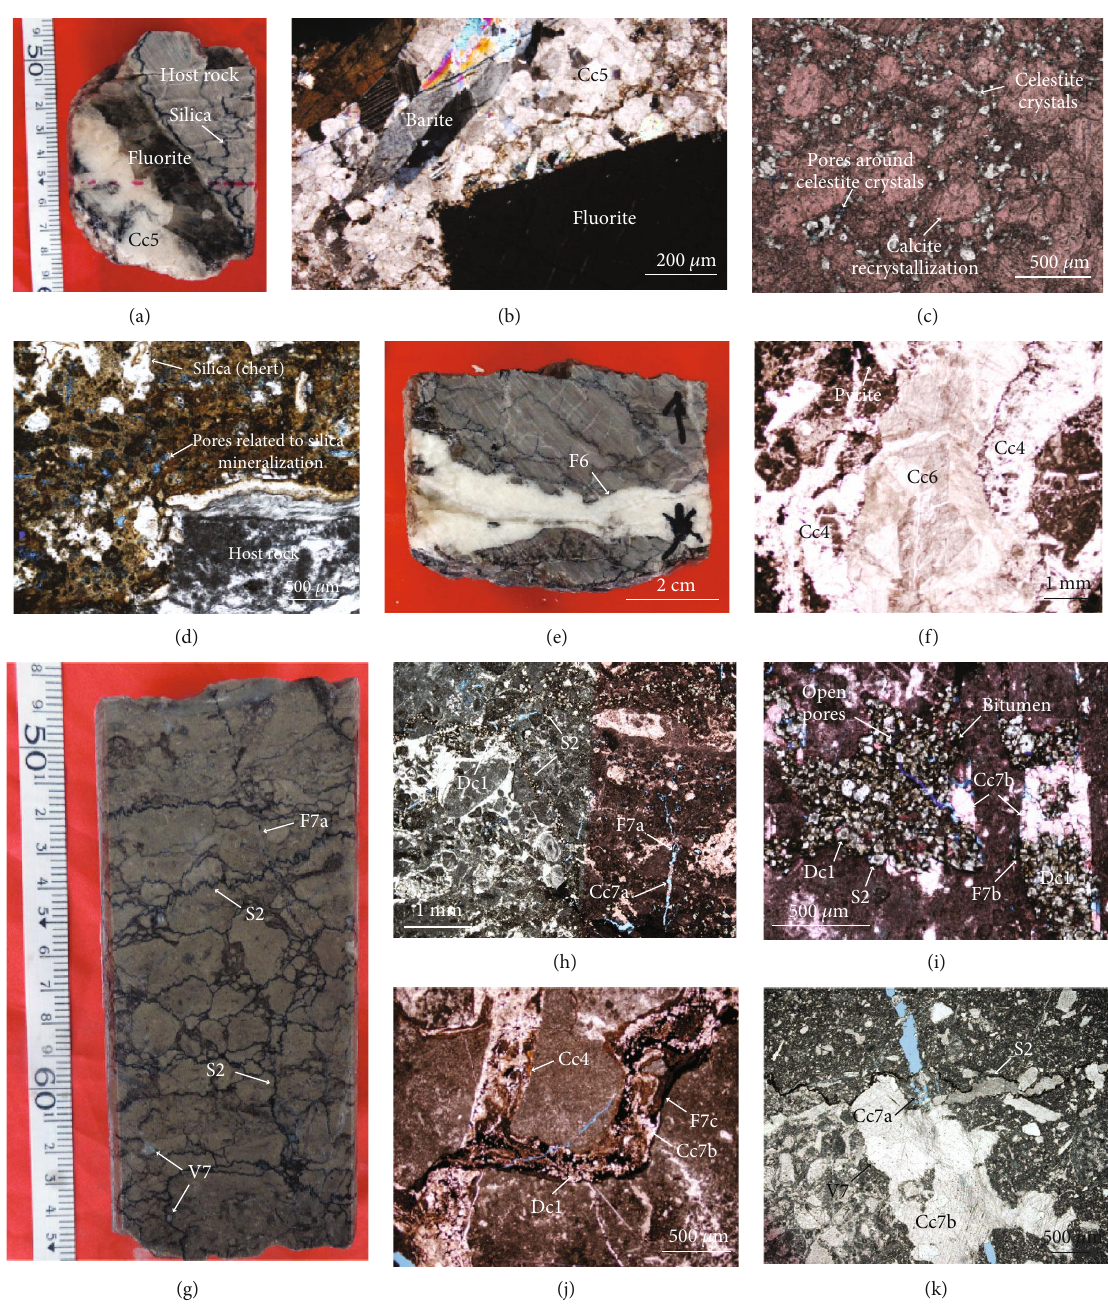
Figure 7: (a) Hand specimen of the Lianglitage Formation showing F5 fractures cemented by fl uorite and calcite (Cc5). Silica mineralization in the host rock along the fracture wall. (b) Plane light optical photomicrograph showing fl uorite, barite, and Cc5a calcite cement precipitated within a F5 fracture. (c) Plane light optical photomicrograph showing recrystallization of host rock by calcite and celestite mineralization. Note pores ( fi lled with blue epoxy) formed around the celestite crystals. (d) Plane-light optical photomicrograph showing partial replacement of the host rock by silica mineralization. Note pores associated with silica replacement. (e) Hand specimen of Yijianfang Formation showing F6 fractures. (f) Plane light optical photomicrograph showing F6 fractures fi lled with Cc6 cement postdating Cc4- bearing F4 fractures. (g) Hand specimen of the Yijianfang Formation showing irregular, multidirectional S2 stylolites that give the rock a pseudonodular appearance (stylobreccia). Note that S2 is associated with F7 fractures and V7 vugs. (h) Plane light optical photomicrograph showing stylobreccias and their association with F7 fractures. Dolomite cement (Dc1) precipitated along S2 stylolites. F7a fractures fi lled with calcite cement (Cc7a). (i) Plane light optical photomicrograph showing F7b fractures and S2 tectonic stylolites containing blocky calcite (Cc7b) and dolomite cement (Dc1). Notice that pores around Dc1 crystals are fi lled with bitumen. (j) Plane light optical photomicrograph showing bedding-oblique stylolitic and sheared F7c fractures containing insoluble material, bitumen, and calcite cement (Cc7b). (k) Plane light optical photomicrograph showing an F7a fracture fi lled with calcite cement (Cc7a) forming synkinematic bridges and V7 vugs fi lled with blocky cement